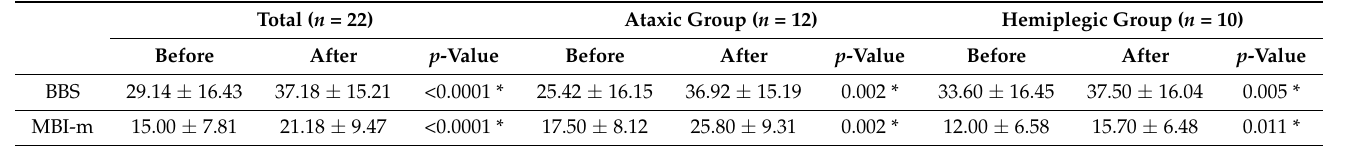
Table 2. Comparative analysis of the BBS and MBI-m within the groups.